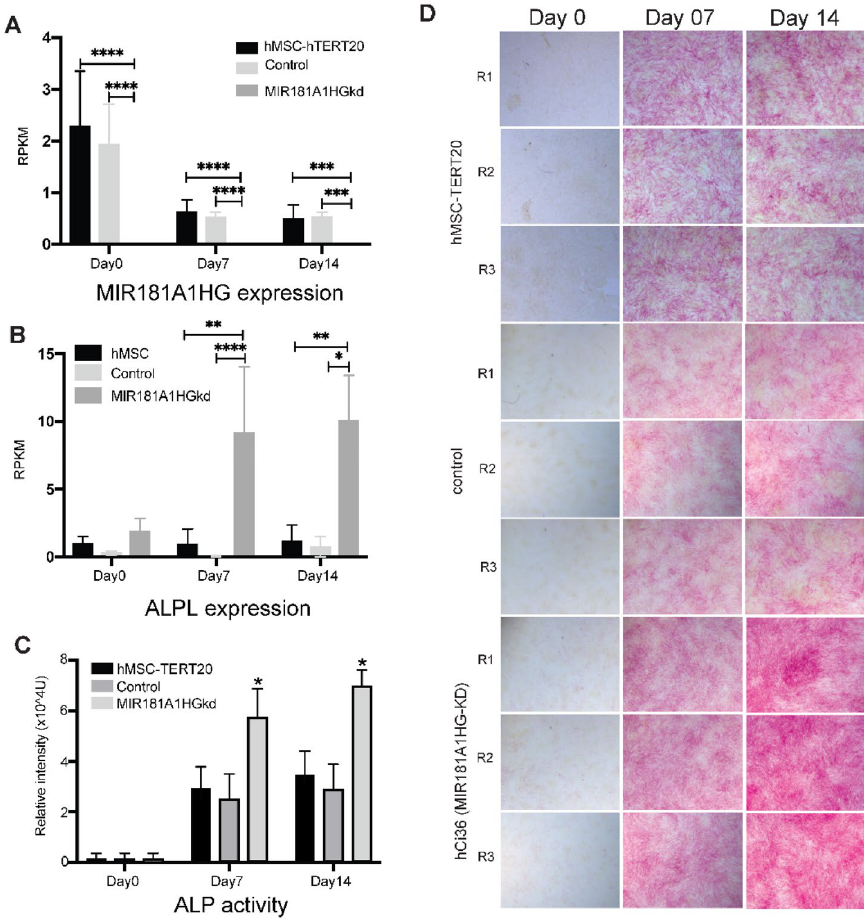
Figure 5. MIR181A1HG knockdown increases ALP expression and activity after osteogenic differentiation. MIR181A1HG was depleted by CRISPRi using dCas9-KRAB and cells were induced to osteogenic differentiation for 14 days. ( A ) MIR181A1HG expression in hMSC-hTERT20, CRISPRi control and MIR181A1HGkd cells by RNA-Seq. ( B ) RNA expression of ALPL from global transcriptome analysis. ( C ) Quantitation of alkaline phosphatase staining from ( D ). ( D ) Cells were stained for ALP activity; MIR181A1HGkd cells showed increased staining at days 7 and 14 compared to parental hMSC-hTERT cells and CRIPSRi controls. *padj < 0.05; **padj < 0.01; ***padj < 0.001; *****padj < 10 –4 (n = 3). Data are presented as mean ±